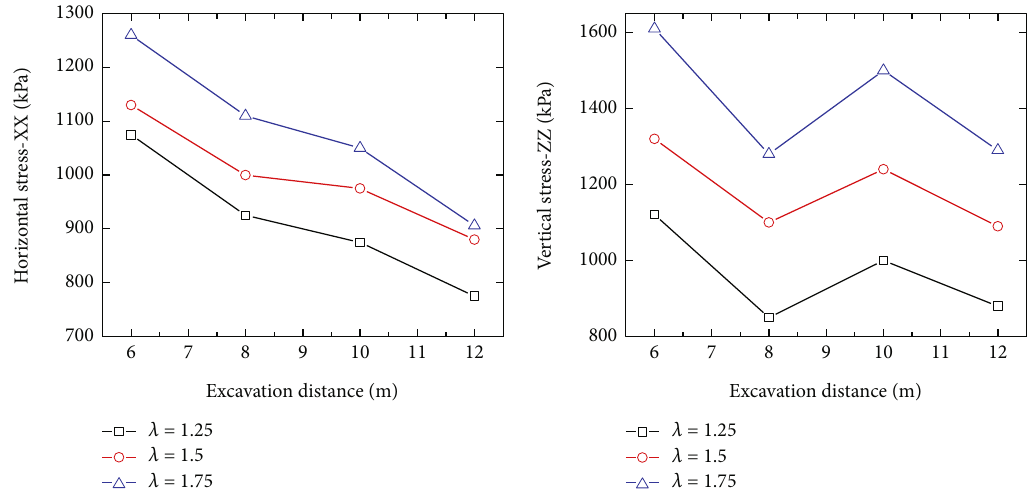
Figure 5: Changes in horizontal stress at the arch waist on the right side and vertical stress at the top of the vault under di ff erent side pressure coe ffi cients.